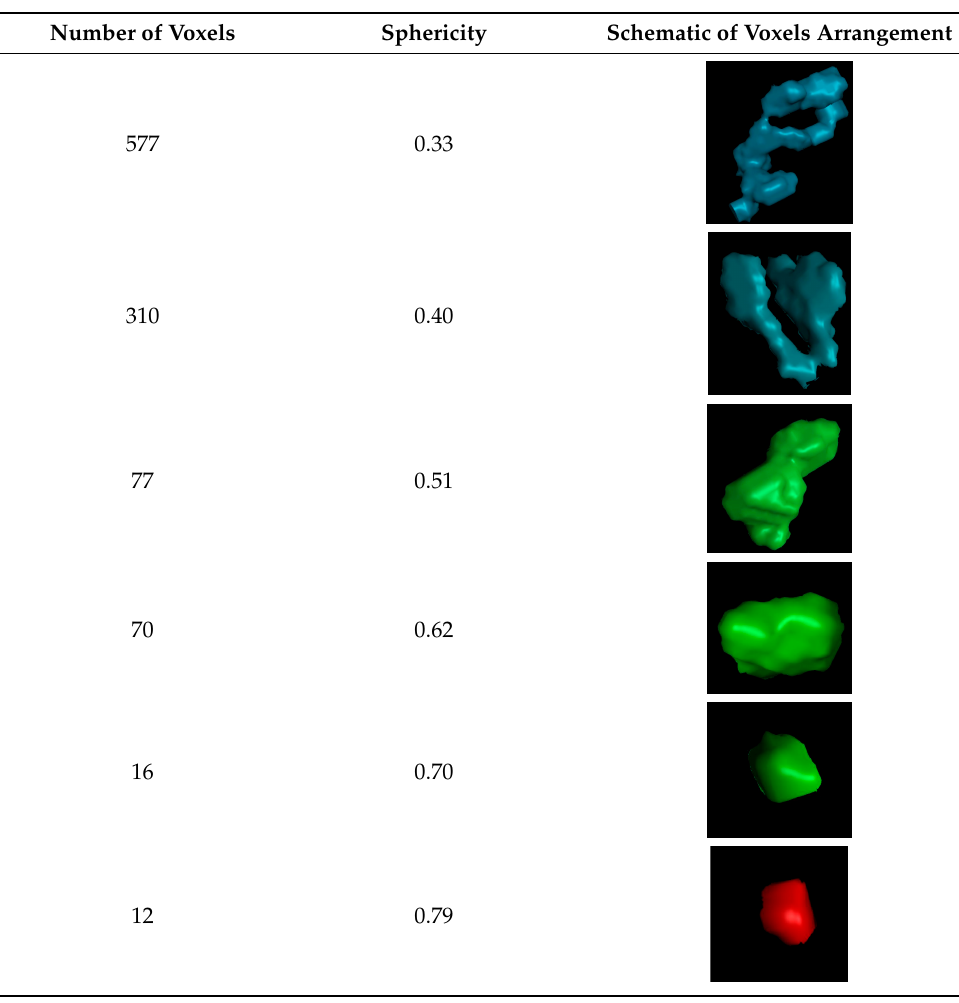
Table 5. Sphericity and number of voxels of several detected voids within the microstructure of a single freely strand.